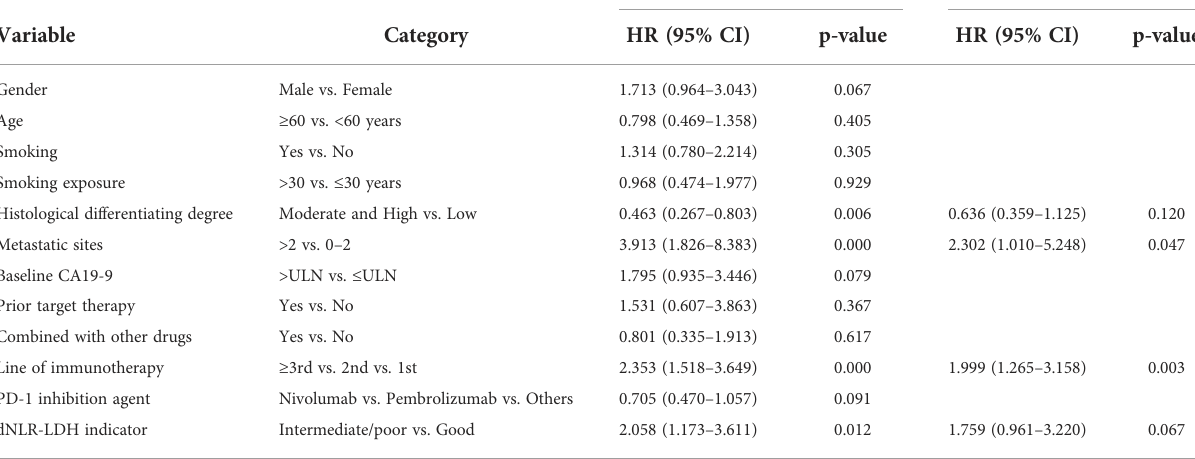
TABLE 4 Univariate and multivariate analysis for PFS in PC patients treated with